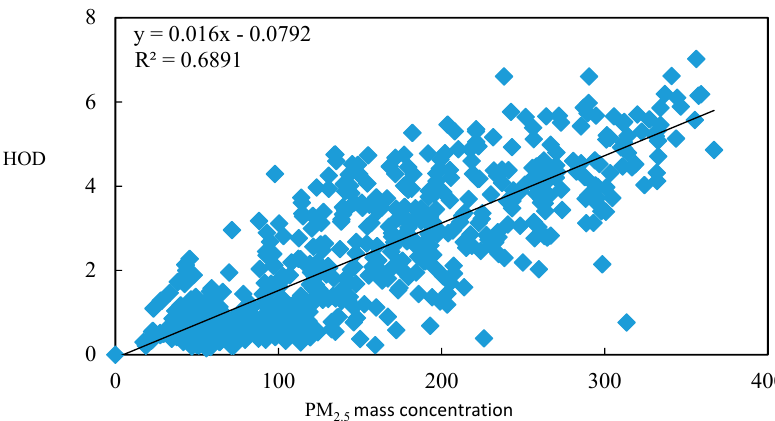
Figure 2. Validation of the HOD inversion results of each ground station compared with PM 2.5 mass